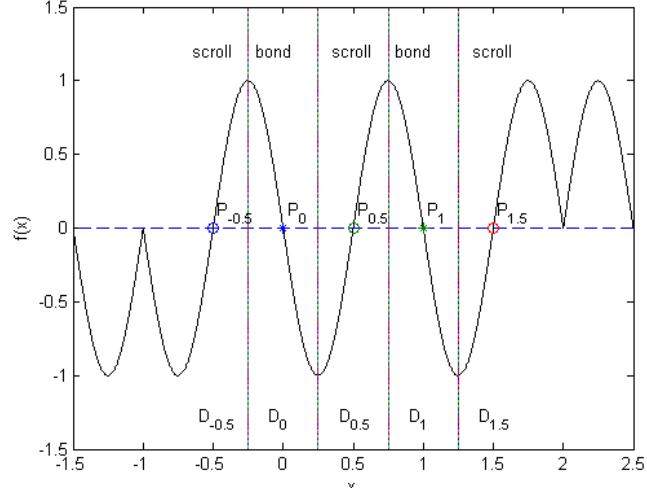
. The five equilibrium points are plotted in Figure 8.